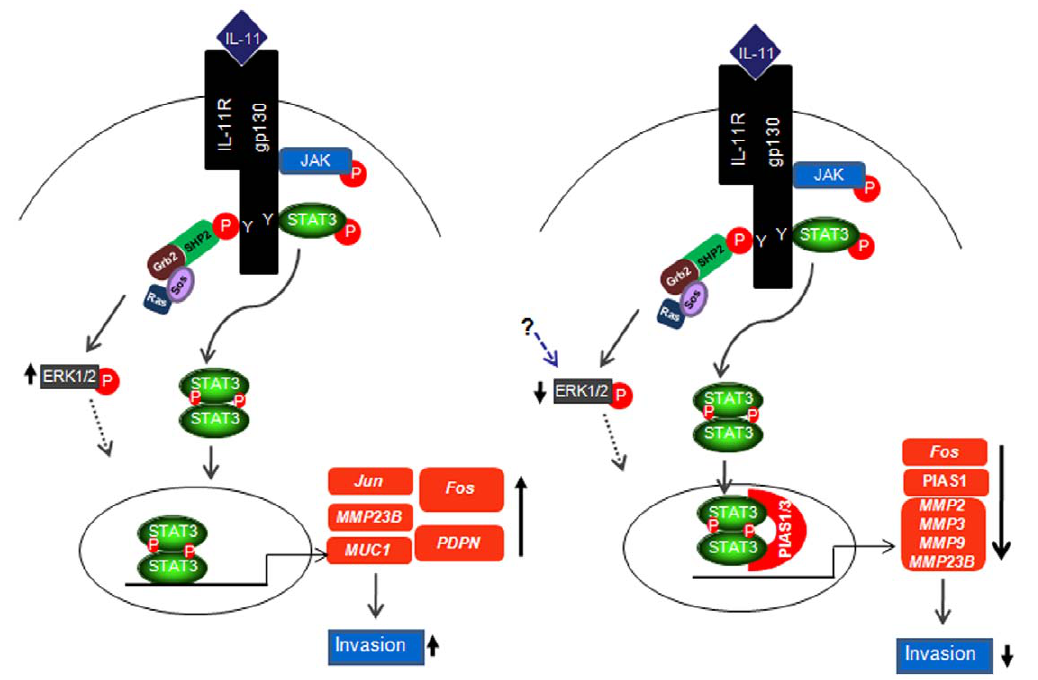
Figure 8. Schematic representation of the IL-11 mediated signaling and gene expression in JEG-3 and HTR-8/SVneo cells. IL-11 treatment to JEG-3 cells led to the activation of STAT1/3, which after dimerization moves into the nucleus. The activation of STAT3 was associated with a transient activation of ERK1/2. Activation of STAT3(tyr705) is associated with its nuclear localization. In effect to these, an increase in the expression of pro-invasive molecules like Jun , Fos , MUC1 , PDPN , MMP23B etc have been observed. In HTR-8/SVneo cells, IL-11 treatment increases the activation of STAT1(tyr701) and STAT3(tyr705) while, decreases the activation of ERK1/2. The increase in p-STAT3(tyr705) was associated with its nuclear localization within 10 min of IL-11 treatment. However, upon IL-11 treatment, there was nuclear co-localization of p-STAT3(tyr705) with its inhibitory factor PIAS1/3. This could be the reason for the decrease in the expression of Fos , MMP2 , MMP3 , MMP9 and MMP23B . (Solid arrows show the confirmed findings while, dotted arrows show the hypothetical links, which needs to be validated. Name of genes written in italics have been confirmed at the RNA level while, other have been confirmed at the protein level.).